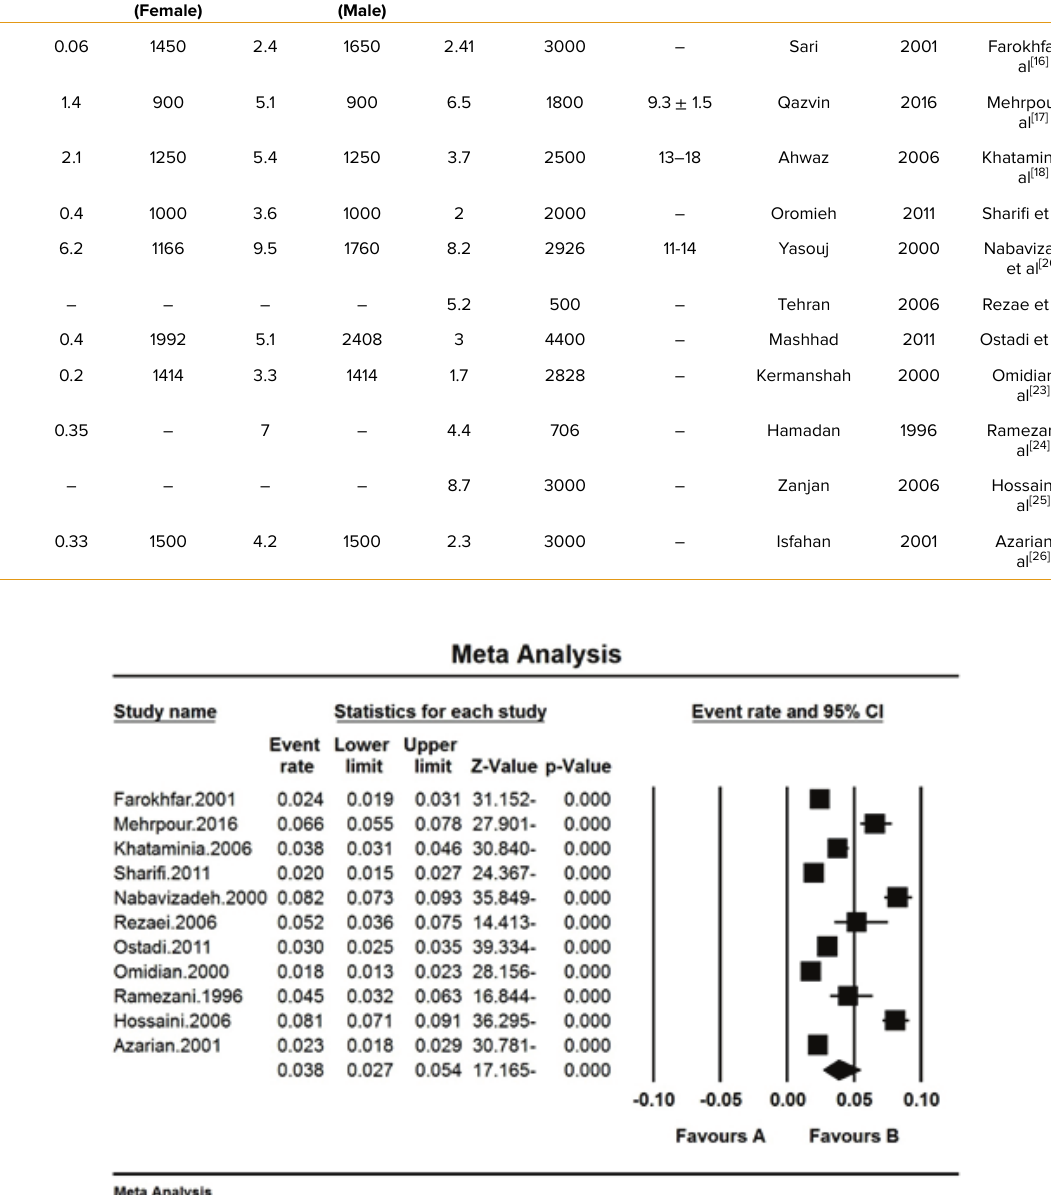
Table 1. Specifications of studies entered into the meta-analysis of the prevalence of color blindness in Iranian students Quality Prevalence assessment (Female)